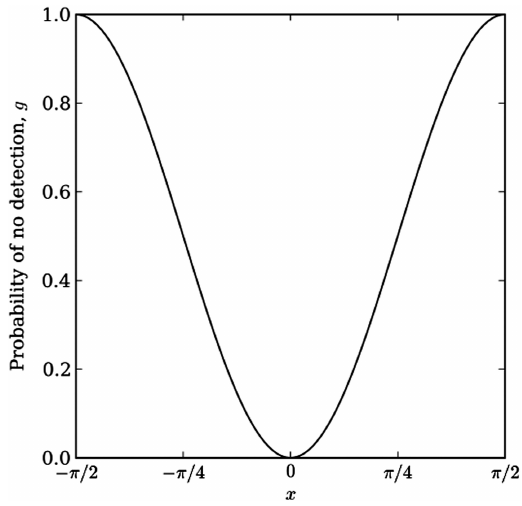
Figure 4. Probability of not detecting a single target as a function of look angle ð θ ¼ π